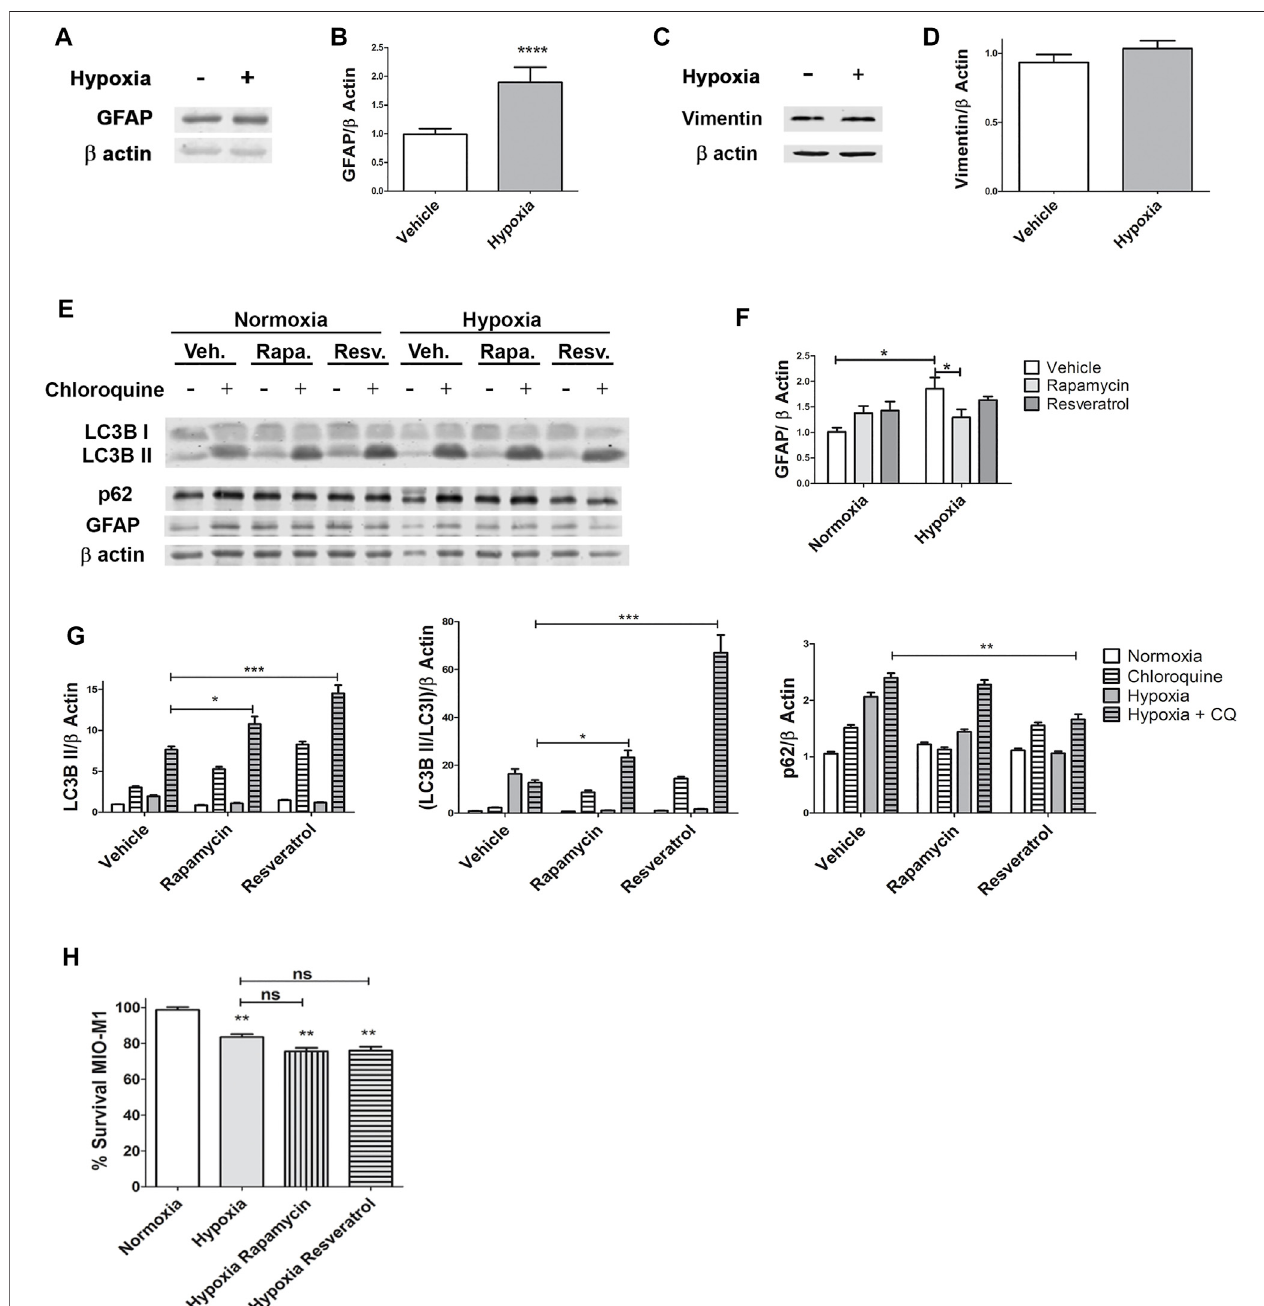
FIGURE 4 | Rapamycin decreases GFAP protein expression in MIO-M1. (A) Representative Western blot of GFAP from cellular lysates of MIO-M1 incubated in hypoxicconditions(1%O 2 )during4 h. (B) ProteinlevelsofGFAPwerequanti fi edbydensitometryandnormalizedto β actin. (C) RepresentativeWesternblotofVimentin from cellular lysates of MIO-M1 incubated in hypoxic conditions (1% O 2 ) during 4 h. (D) Protein levels of vimentin were quanti fi ed by densitometry and normalized to